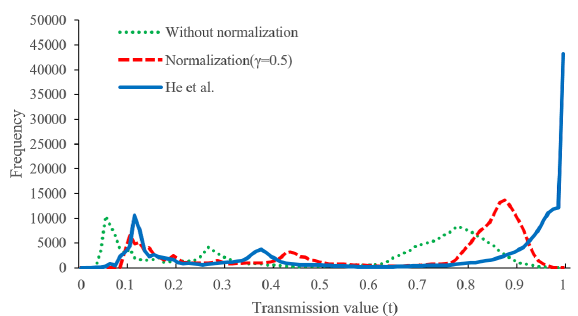
Figure 3. Histogram of medium transmission with each method.